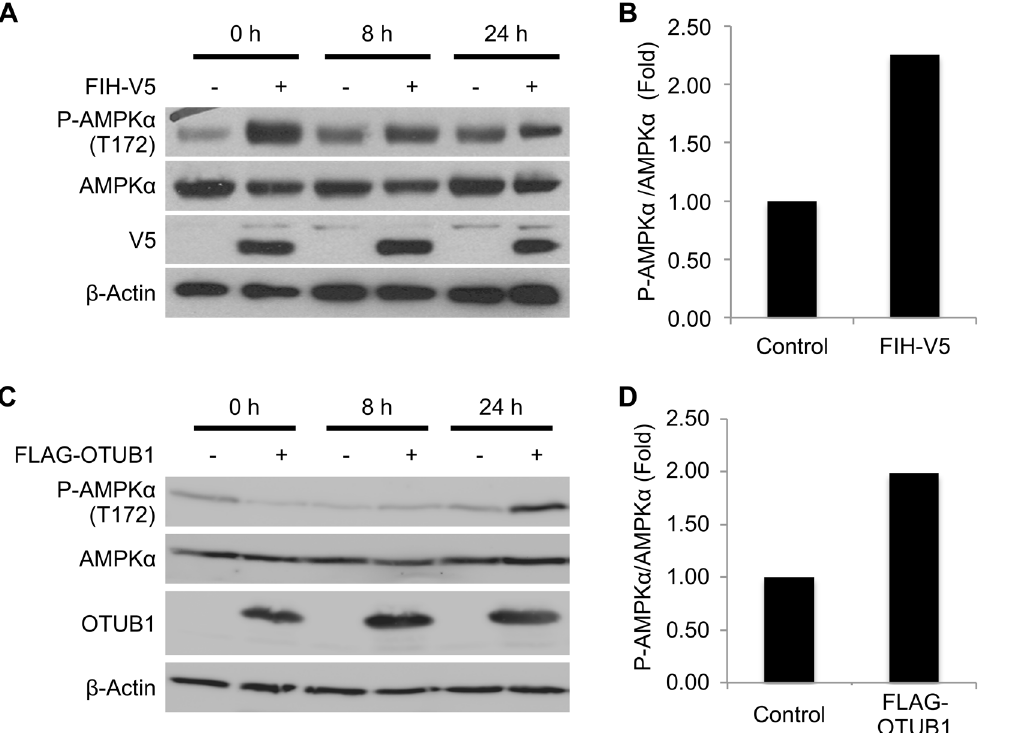
Fig 1. FIH and OTUB1 regulate cellular metabolism. (A) Western blot analysis of the impact of FIH overexpression on phosphorylation of AMPK α on T172 in HEK293 cells. Cells were transfected with either an empty vector or FIH-V5 for 24 h prior to media change. Phospho-AMPK α , total AMPK α , β -actin, and FIH-V5 expression were assessed for up to 24 h following the addition of fresh medium by western blot. (B) Densitometric analysis of AMPK α phosphorylation at the time point 0 h. (C) Analysis of the impact of OTUB1 WT overexpression on phosphorylation of AMPK α (T172) in HEK293 cells. Cells were transfected with either an empty vector or pFLAG-OTUB1 WT for 24 h prior to media change, and phospho-AMPK α , total AMPK α , β -actin, and FLAG- OTUB1 expression were assessed for up to 24 h by western blot. (D) Densitometric analysis of AMPK α phosphorylation at the time point 24 h. Data are presented as a representative blot or mean densitometric analysis derived from n = 4 independent experiments. The underlying data of panels B and D can be found in S1